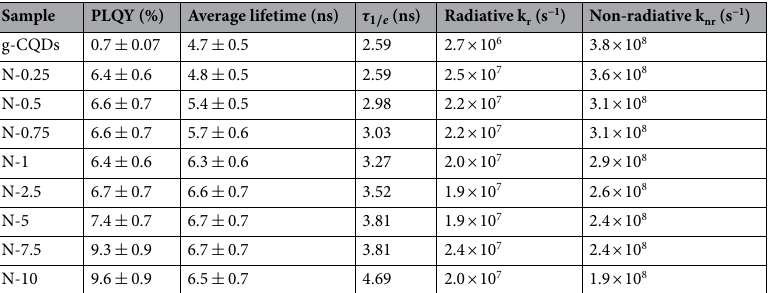
Table 1. The photoluminescence quantum yield (PLQY), average lifetime, 1/e lifetime, radiative (k r ) and non- radiative (k nr ) rates of